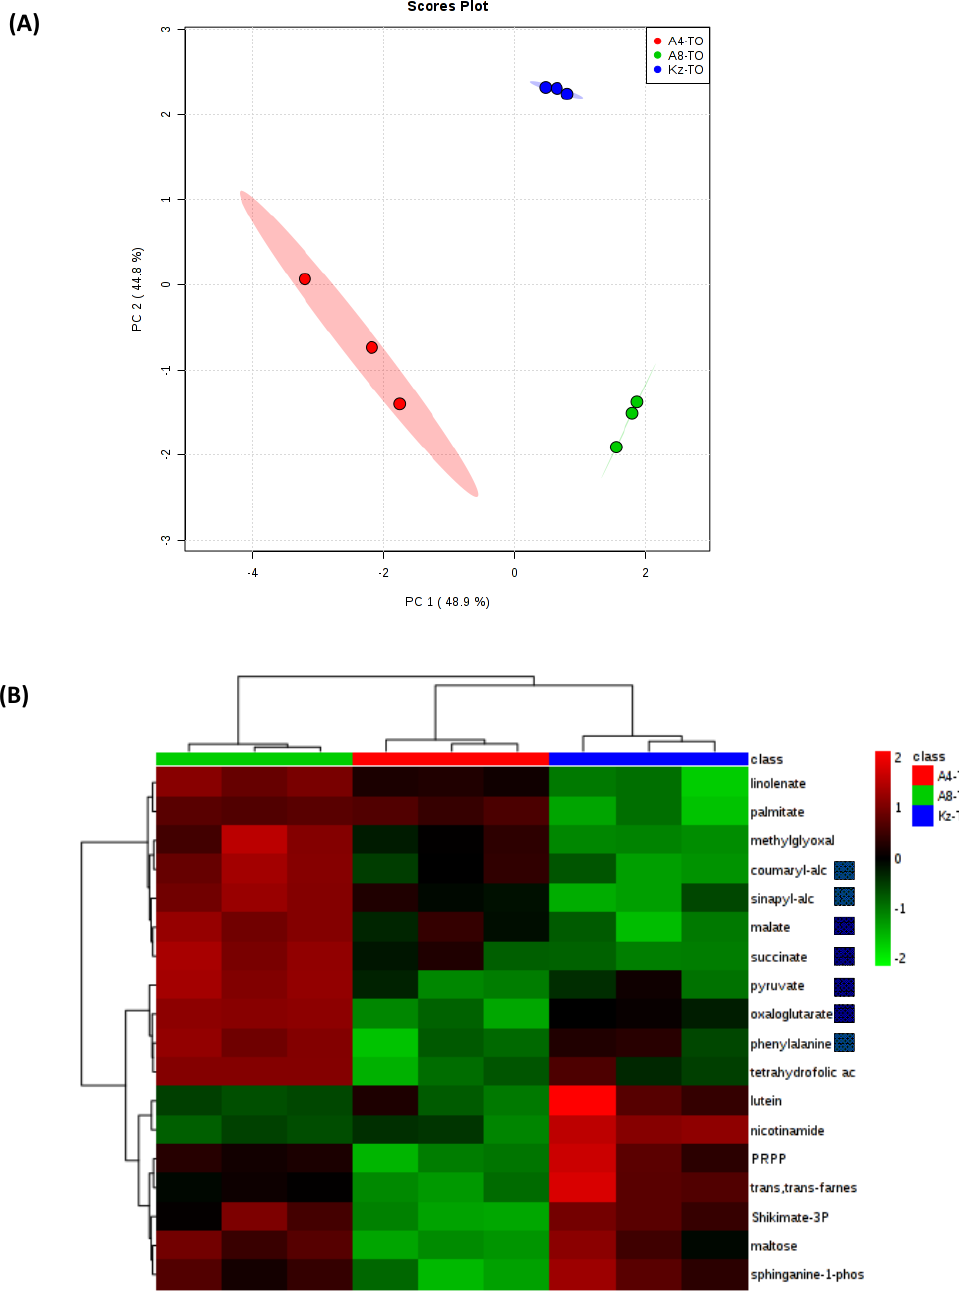
Figure 8. (A) Principal Component Analysis of metabolite profiles the three Brachypodium distachyon genotypes ABR8 [A8], ABR4 [A4] and KOZ1[KZ]) in well –watered controls (T0). (B) Also shown as heat maps are significantly significant metabolite changes (P< 0.05; FDR <0.05) for each accession. Metabolites highlighted in yellow are associated with bioenergetic metabolism and in orange, cell walls.